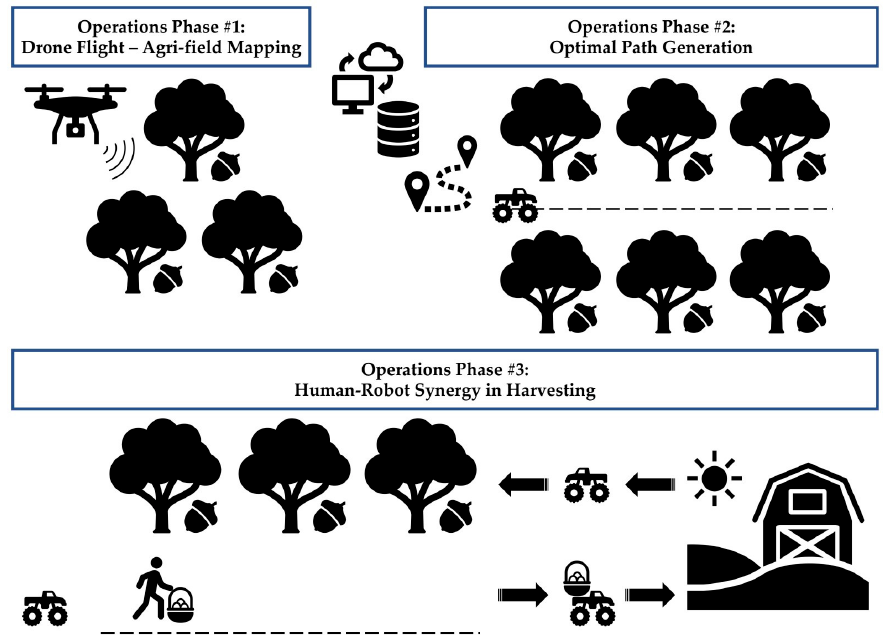
Figure 4. Operations scenario of the human–robot synergy system.